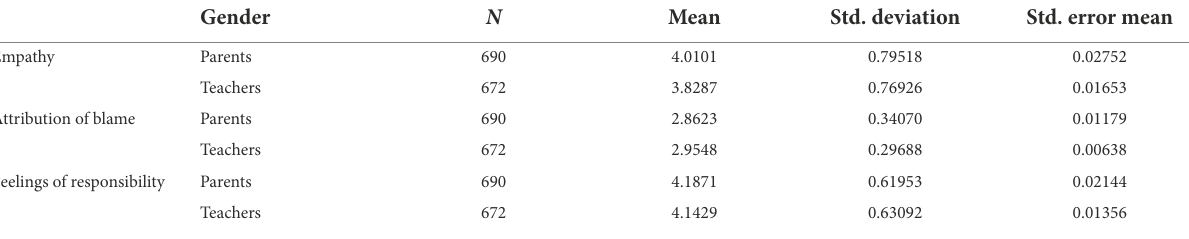
TABLE 5 Group statistics on empathy, attribution of blame, and feelings of responsibility between parents and teachers.